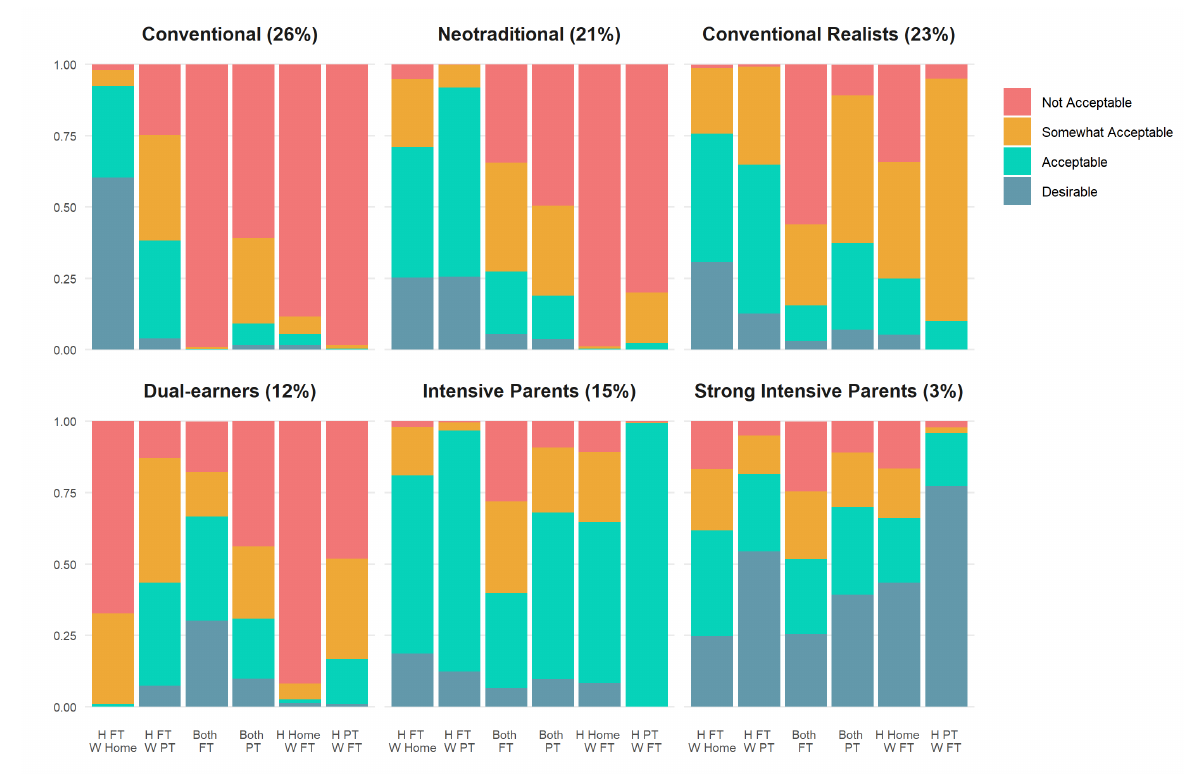
Figure 2: Predicted proportion of evaluations for each arrangement by class. Detailed conditional probabilities for responses to each division of labor arrangement by class are available in Table D of the online supplement. FT, full time; H, husband; PT, part time, W,